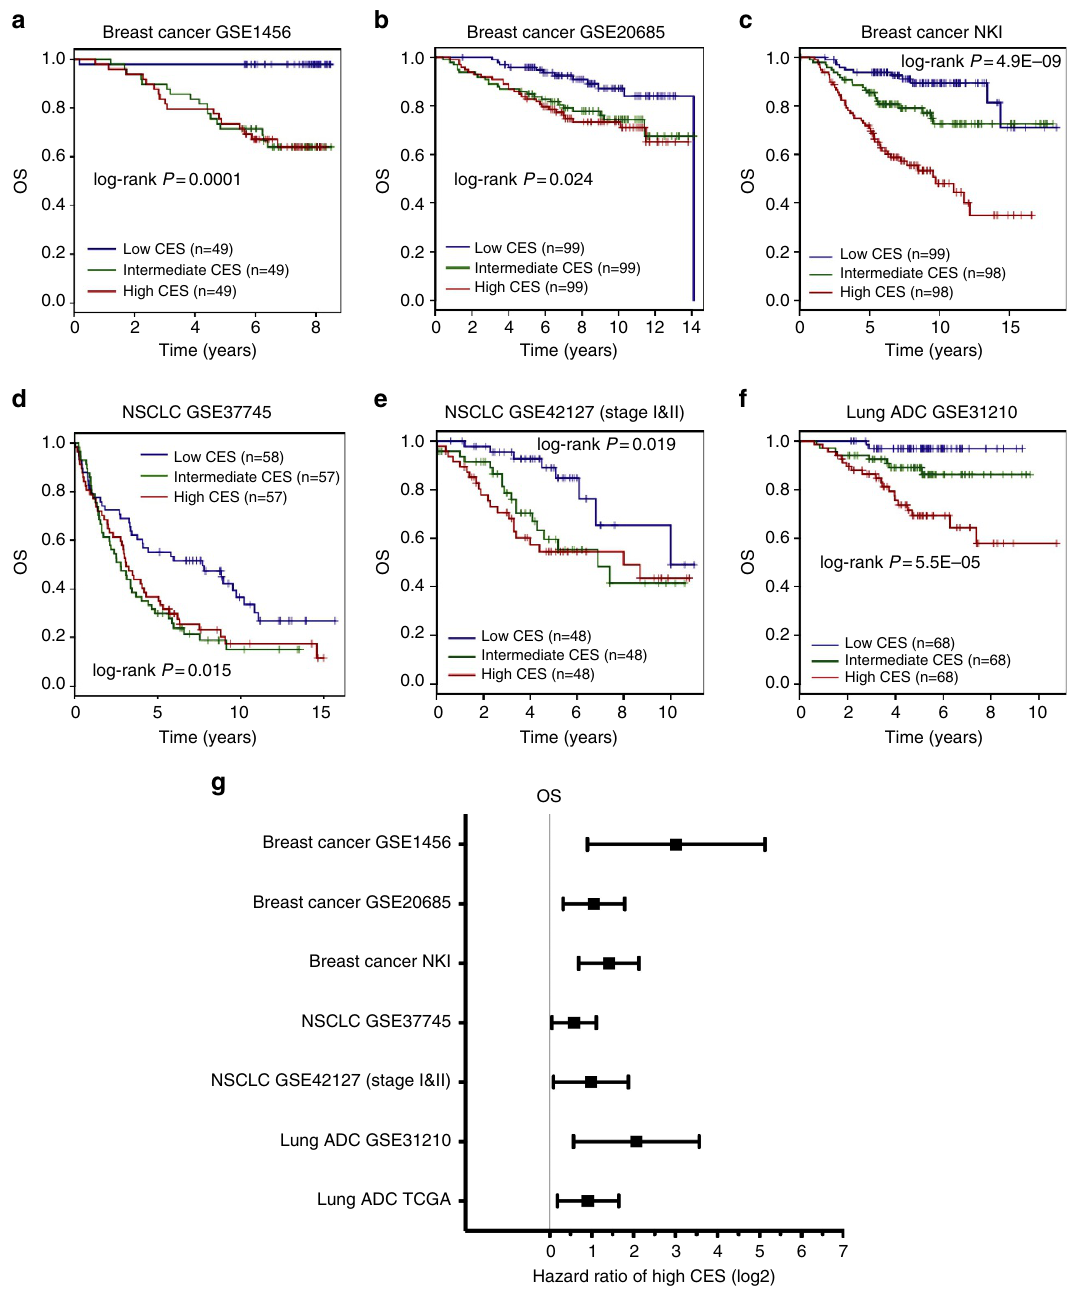
Figure 3 | CES signature is prognostic for cancer patient overall survival. ( a – f ) Kaplan–Meier survival estimations for individual breast cancer and lung cancer data sets for overall survival (OS). Each cohort was divided into CES high (red), intermediate (blue) and low (green) tertiles. Sample sizes and log-rank P values are indicated. ( g ) Forest plot summarizing prognostic impact of CES on patient OS by multivariate Cox regression using individual data sets. Squares and error bars in the plots denote log2 scales of hazard ratio (HR) and 95% confidence interval (CI), respectively. See details for multivariate Cox regression analysis for each data set in Supplementary Tables 15–25. Breast cancer NKI data set, lung ADC GSE31210 data set and NSCLC UT SPORE GSE42127 subcohort contain only stage I and II